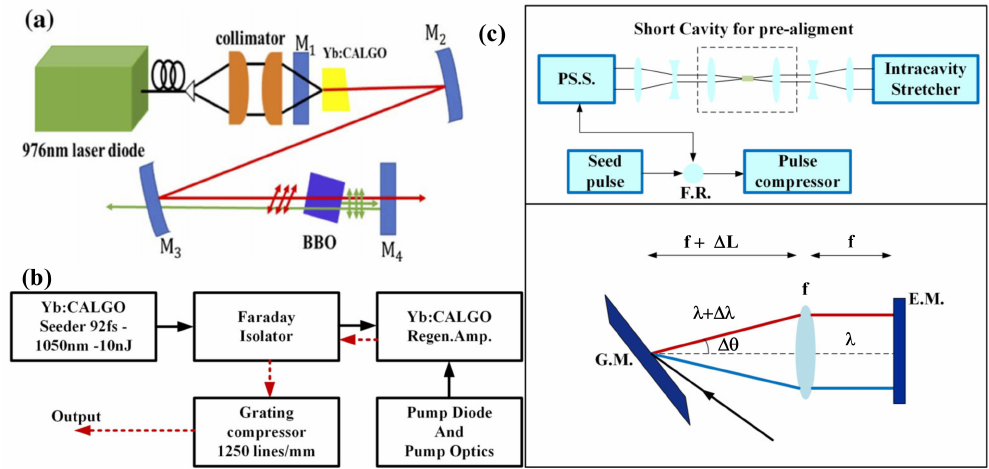
Figure 5. ( a ) Ultrashort pulses Yb:CALGO lasers with nonlinear mirror ML scheme [114]. ( b ) The first Yb:CALGO RA [115]. ( c ) A new intracavity pulse stretching design by exploiting a single grating mirror [117]. ( a ) Reprinted by permission from ref. [114], Springer Nature. ( b , c ) are redrawn based on ref. [116] and ref. [118],